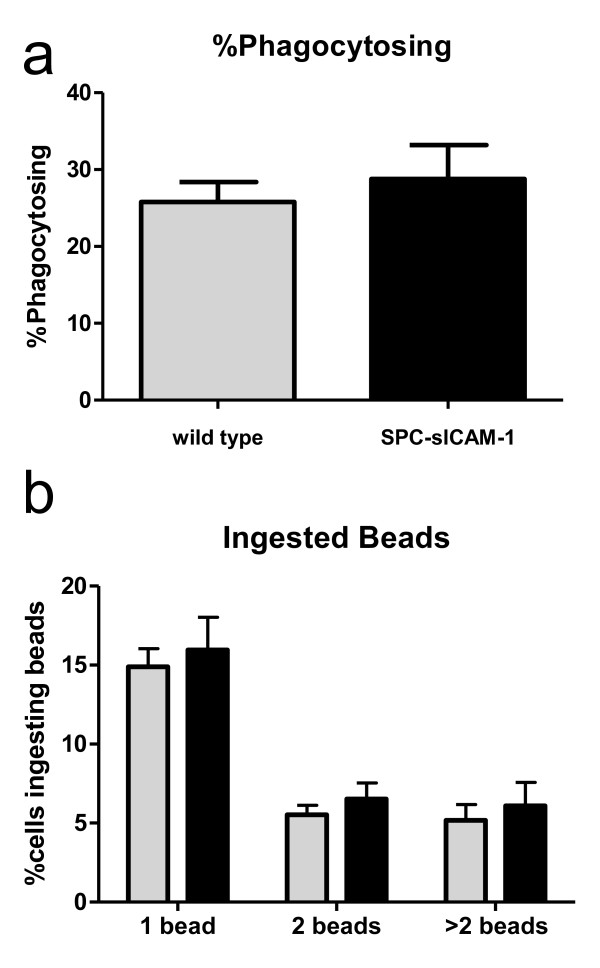
In vivo phagocytosis of labeled microbeads by AM is similar in SPC-sICAM-1 and wild-type mice. Mice were lightly anesthetized and intranasally inoculated with 5 × 107 FITC-conjugated polystyrene microbeads (1.7 micron). After 1 hour, mice were euthanized, and AM were recovered by whole lung lavage. Cells were recovered by centrifugation and examined by flow cytometry. Data are expressed as mean ± SEM for the percentage of AM that have engulfed beads (A) and the percentage of cells ingesting 1, 2, or > 2 beads (B). (n = 5 for all groups; no significant differences between groups)